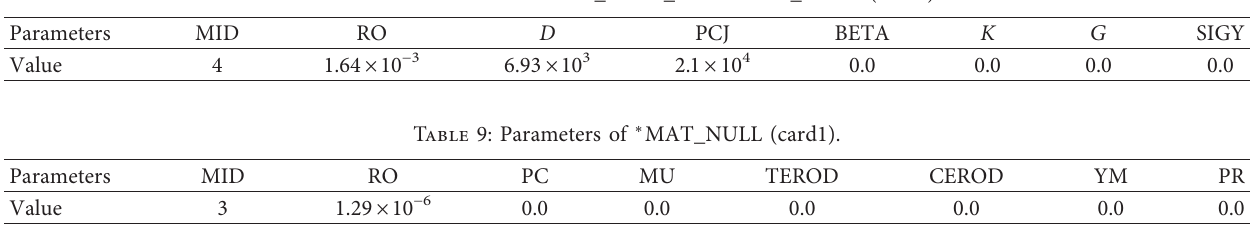
Table 8: Parameters of ∗ MAT_HIGH_EXPLOSIVE_BURN (card1).